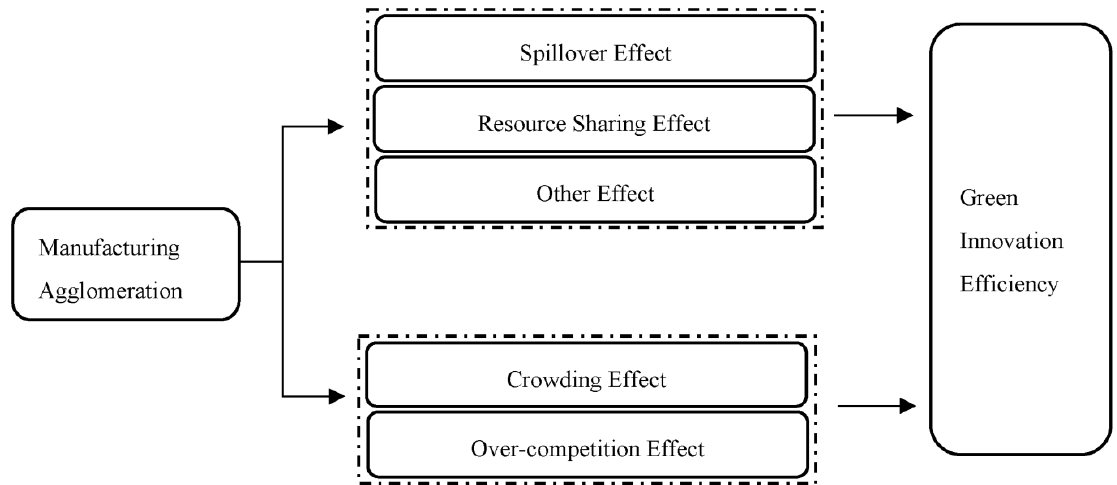
Figure 1. Effect Mechanism of MAGG on GIE.